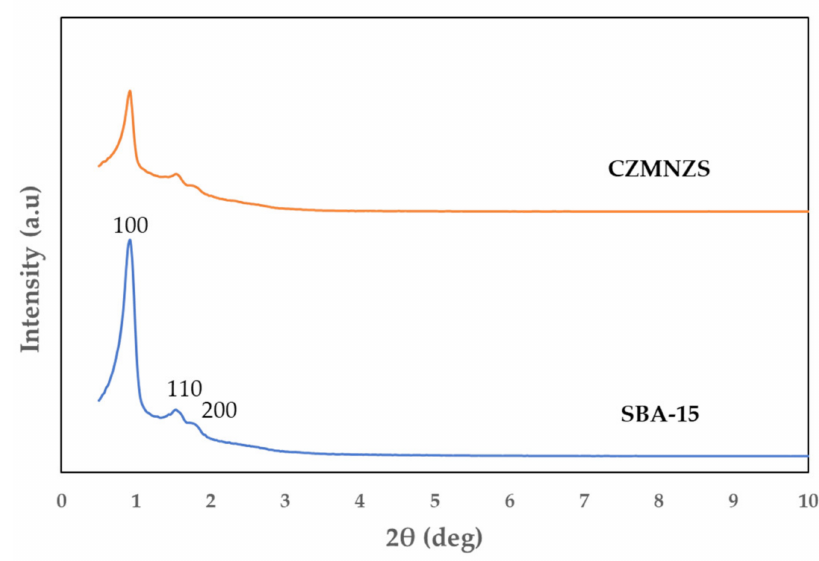
Figure 8. Low-angle XRD patterns of SBA-15 and